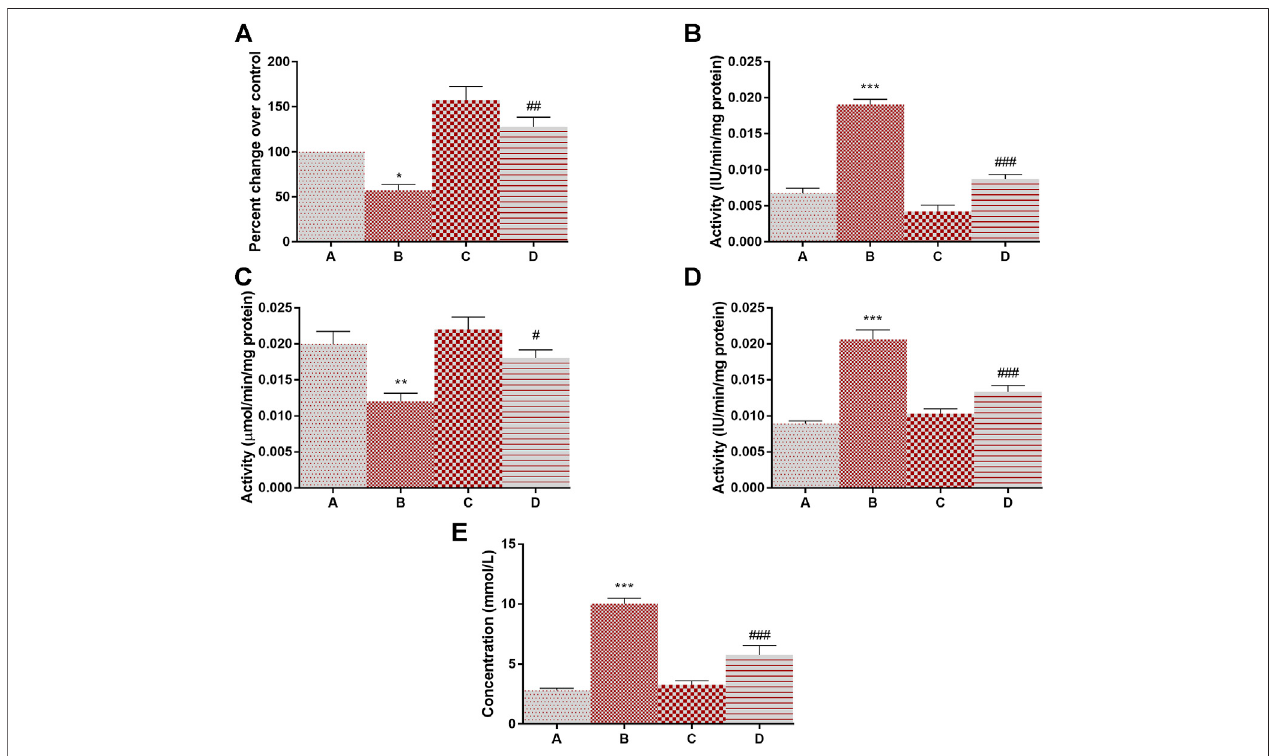
FIGURE 4 | The activity of succinate dehydrogenase, lactate dehydrogenase, fructose-1,6-bisphosphatase, phosphogluconate dehydrogenase, and levels of lactate content in response to 4-(methylthio)butyl isothiocyanate and DMBA. (A) Succinate dehydrogenase, (B) Lactate dehydrogenase, (C) Fructose-1,6-